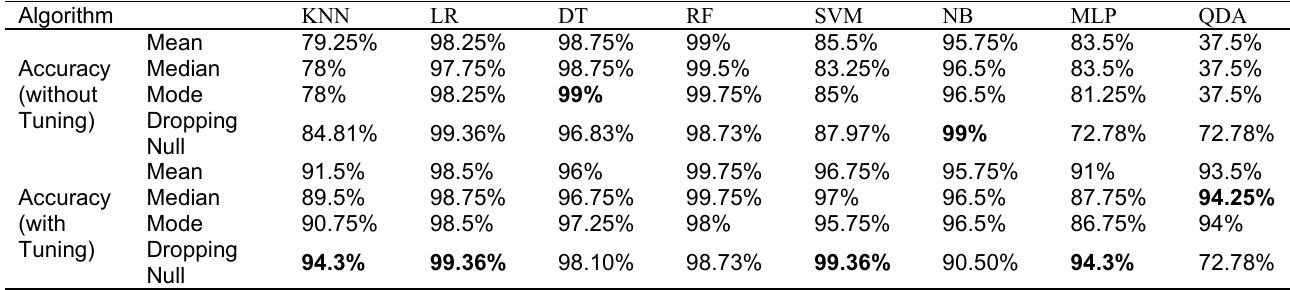
Table 10. Comparison of Accuracy of different ML algorithms